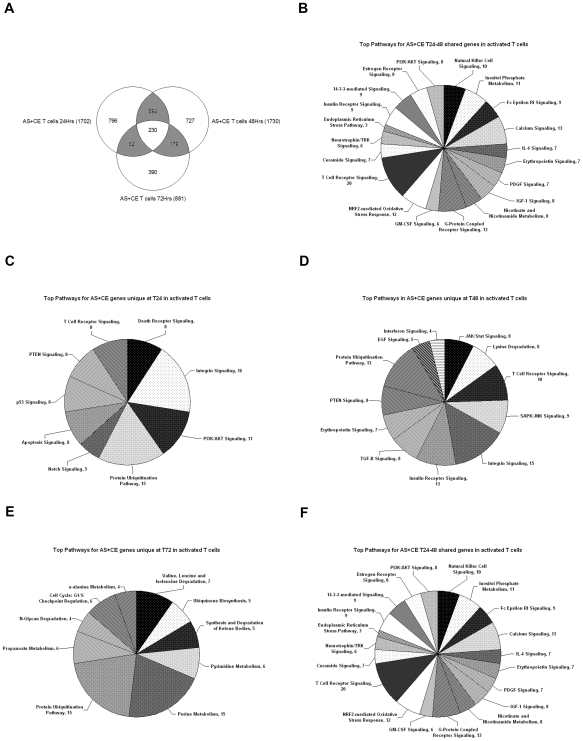
Alternatively spliced/constitutively expressed T cell genes (p<0.001) unique to each activation time-point populate canonical pathways for immune/inflammation.(A) Venn diagram representing the alternatively spliced/constitutively expressed (AS+CE) genes detected at 24, 48, and 72 hours in activated T cells, with total number of detected genes per time point shown in parenthesis, number of genes unique to each time point shown by the number inside the circle and number of genes shared between time points in the shaded overlapping areas, with number of genes detected at all three time points shown in the central overlap. (B–F) Pie charts representing the Ingenuity Pathway Analysis output for the top canonical pathways populated by AS+CE genes during T cell activation: (B) shared at all time points, (C) genes unique to 24 hour time-point, (D) genes unique to the 48 hour time-point, (E) genes unique to the 72 hour time-point, (F) genes uniquely detected during the transition between 24 and 48 hour time-points. Numbers next to pathway name indicate the number of detected genes that are assigned to each pathway. The size of each shaded slice is proportional to the number of genes per pathway compared to total number of genes per chart.